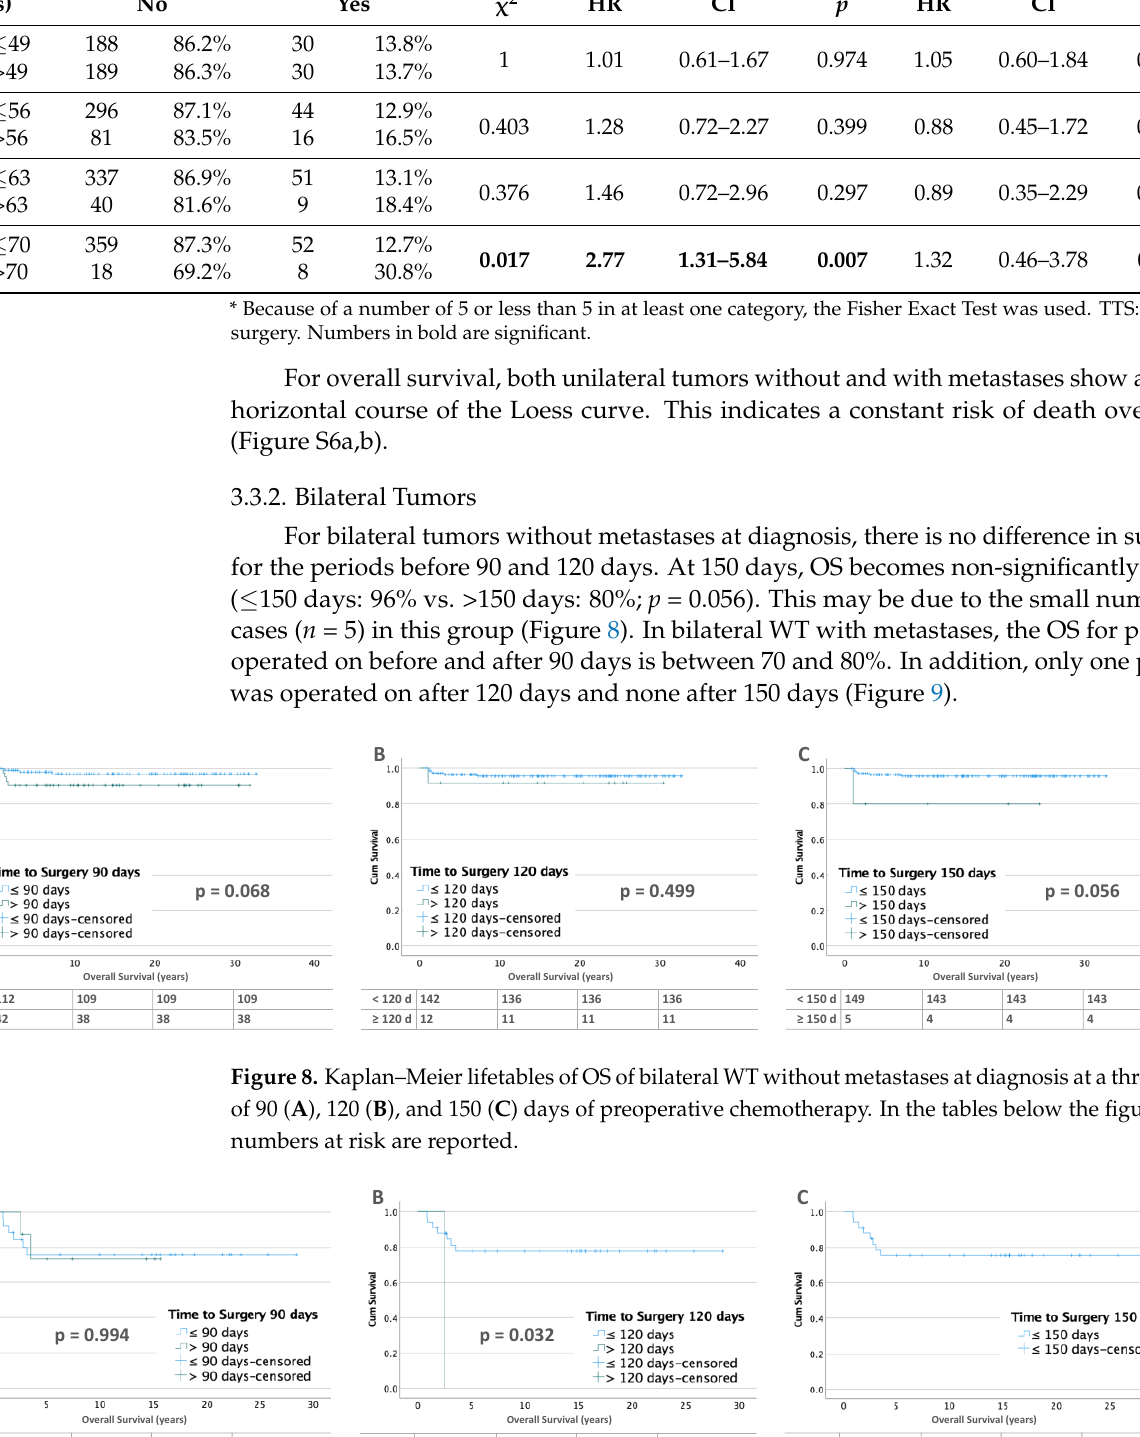
Table 4. Results of univariate und multivariate regression analysis of the impact of TTS on OS at different time points for patients with bilateral WT with and without metastases at diagnosis.